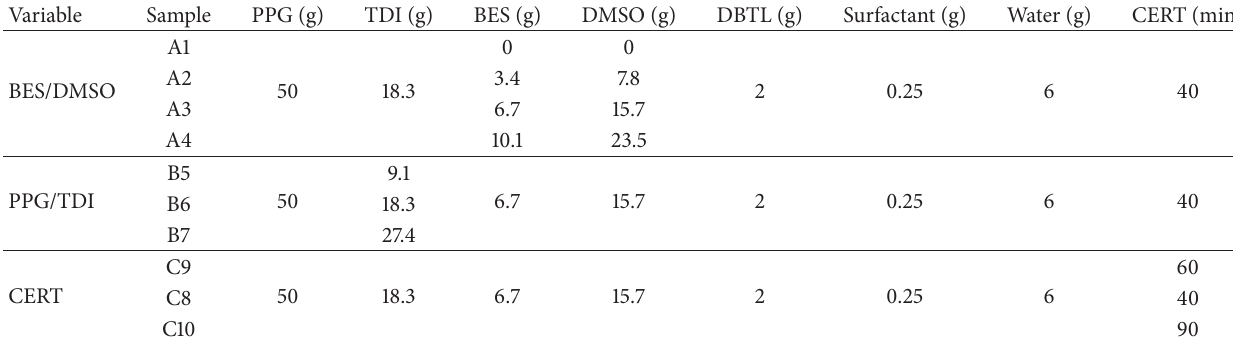
Table 1: Foam composition based on various processing